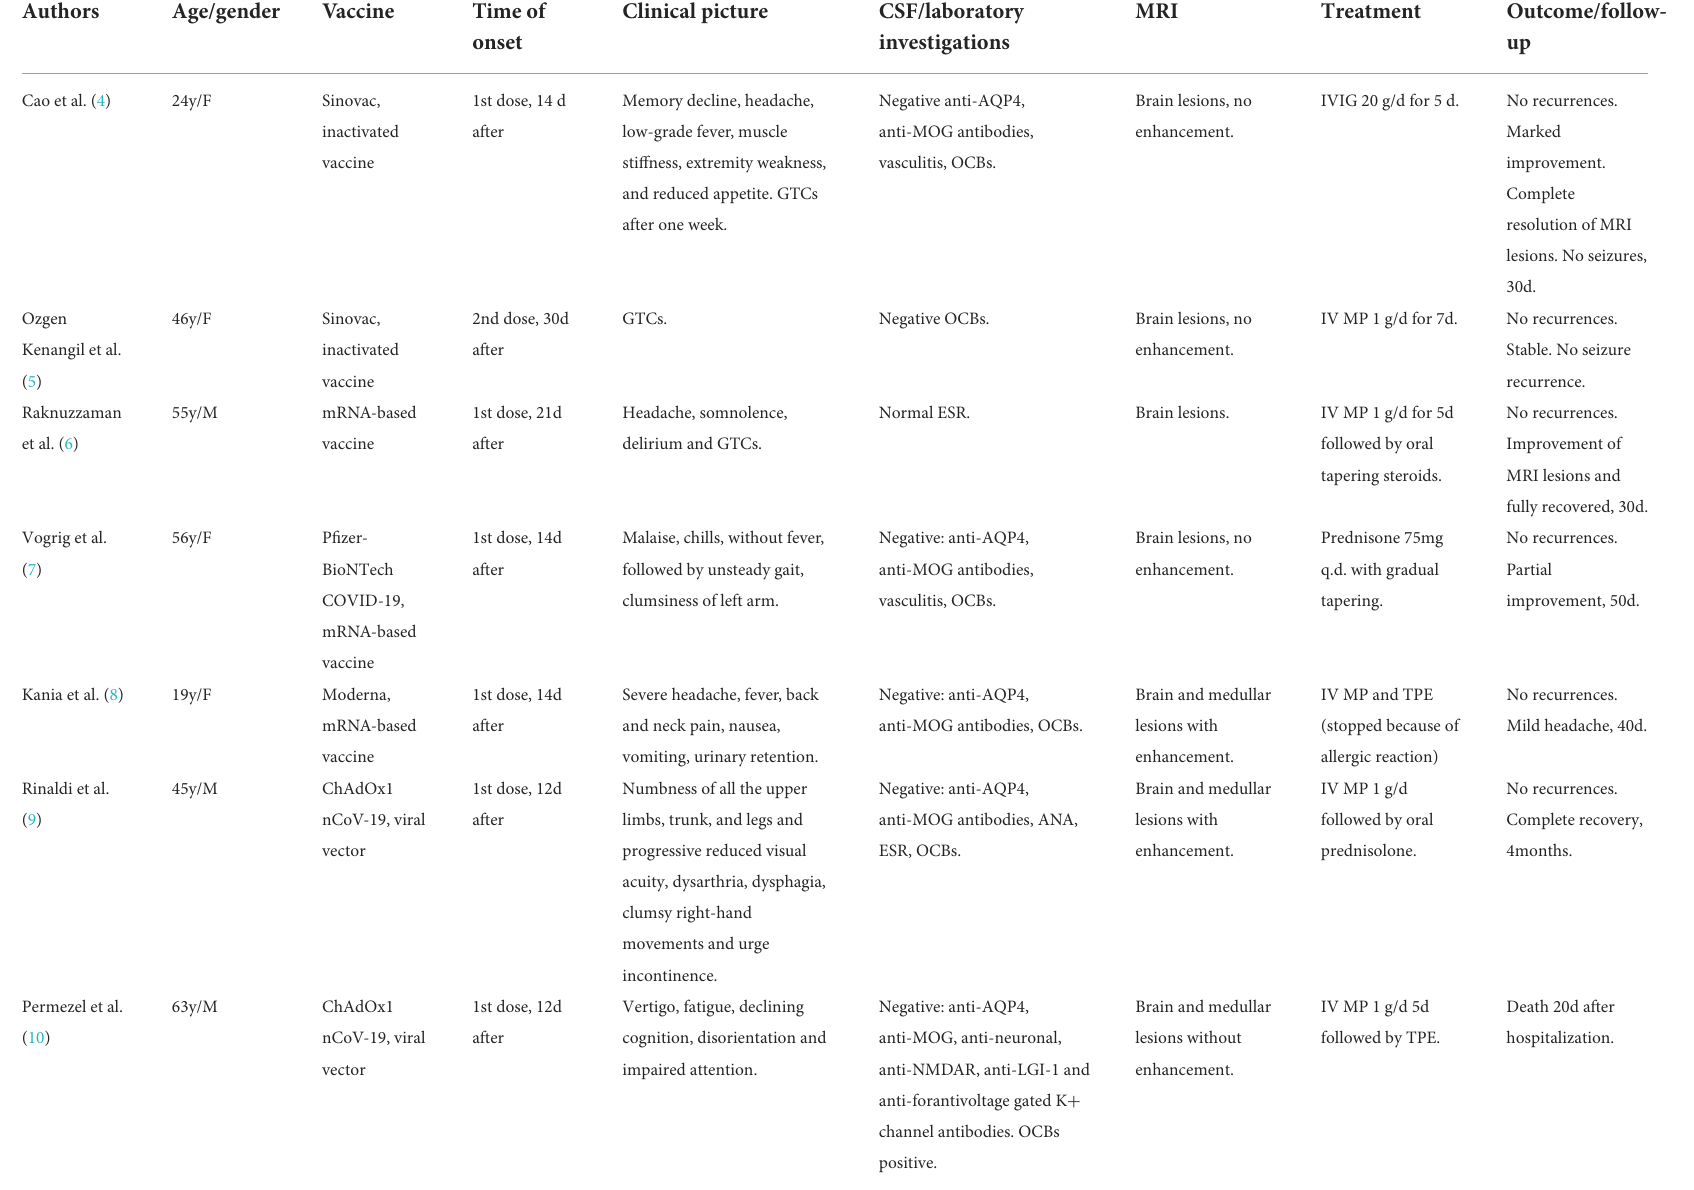
TABLE 2 Clinical and demographic characteristics of the 6 cases reporting with an ADEM post COVID